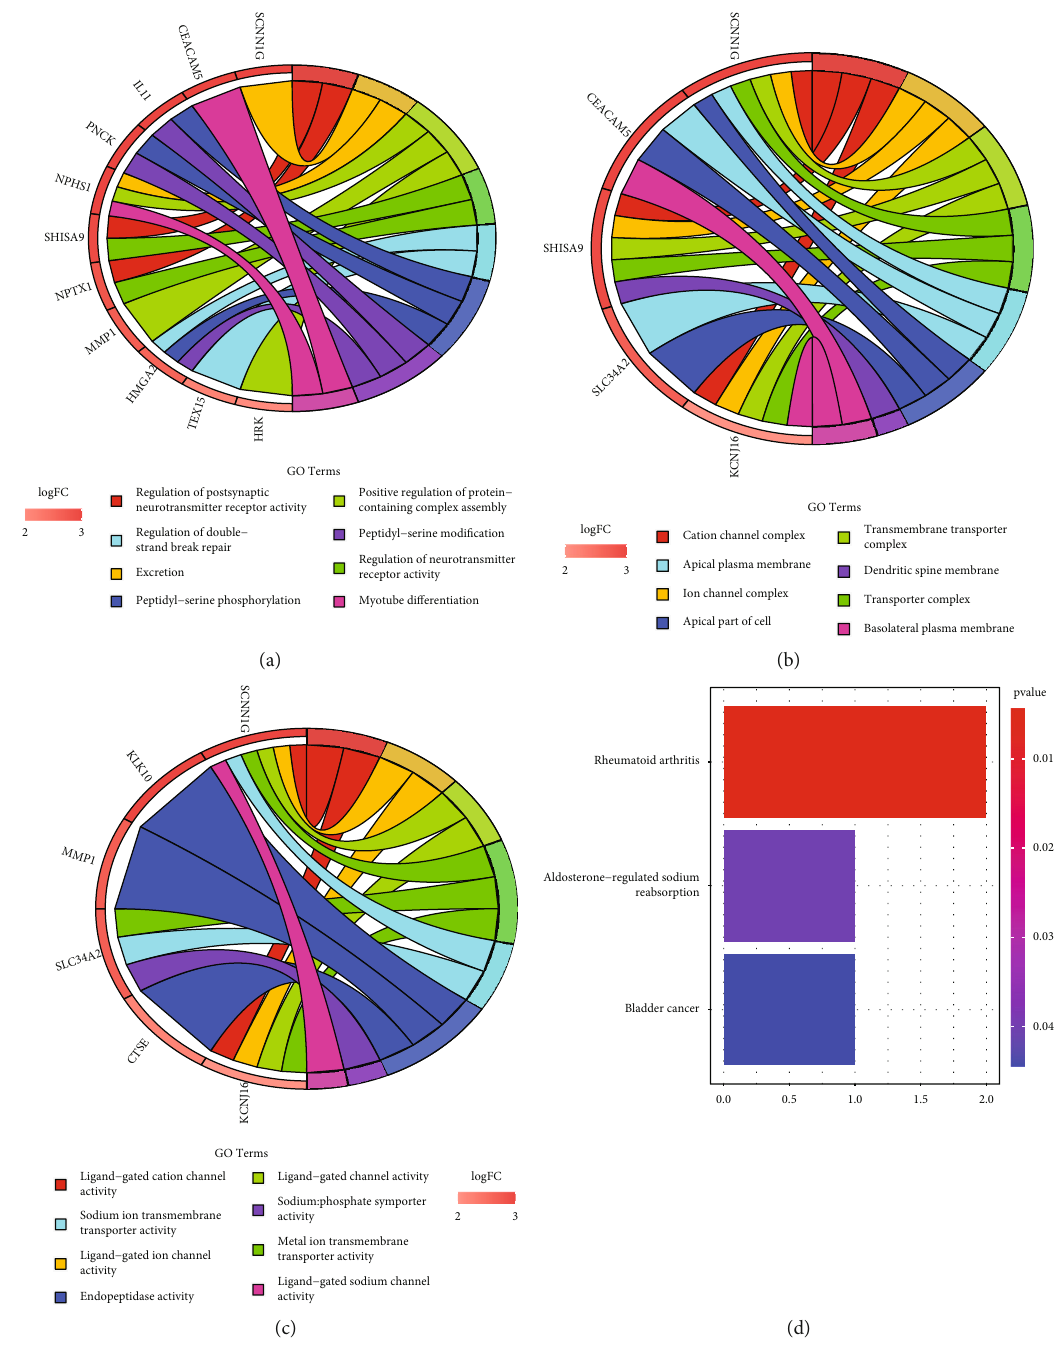
Figure 2: GO and KEGG assays of the 21 genes. Circle plot of (a) BP, (b) CC, and (c) MF assays. (d) KEGG